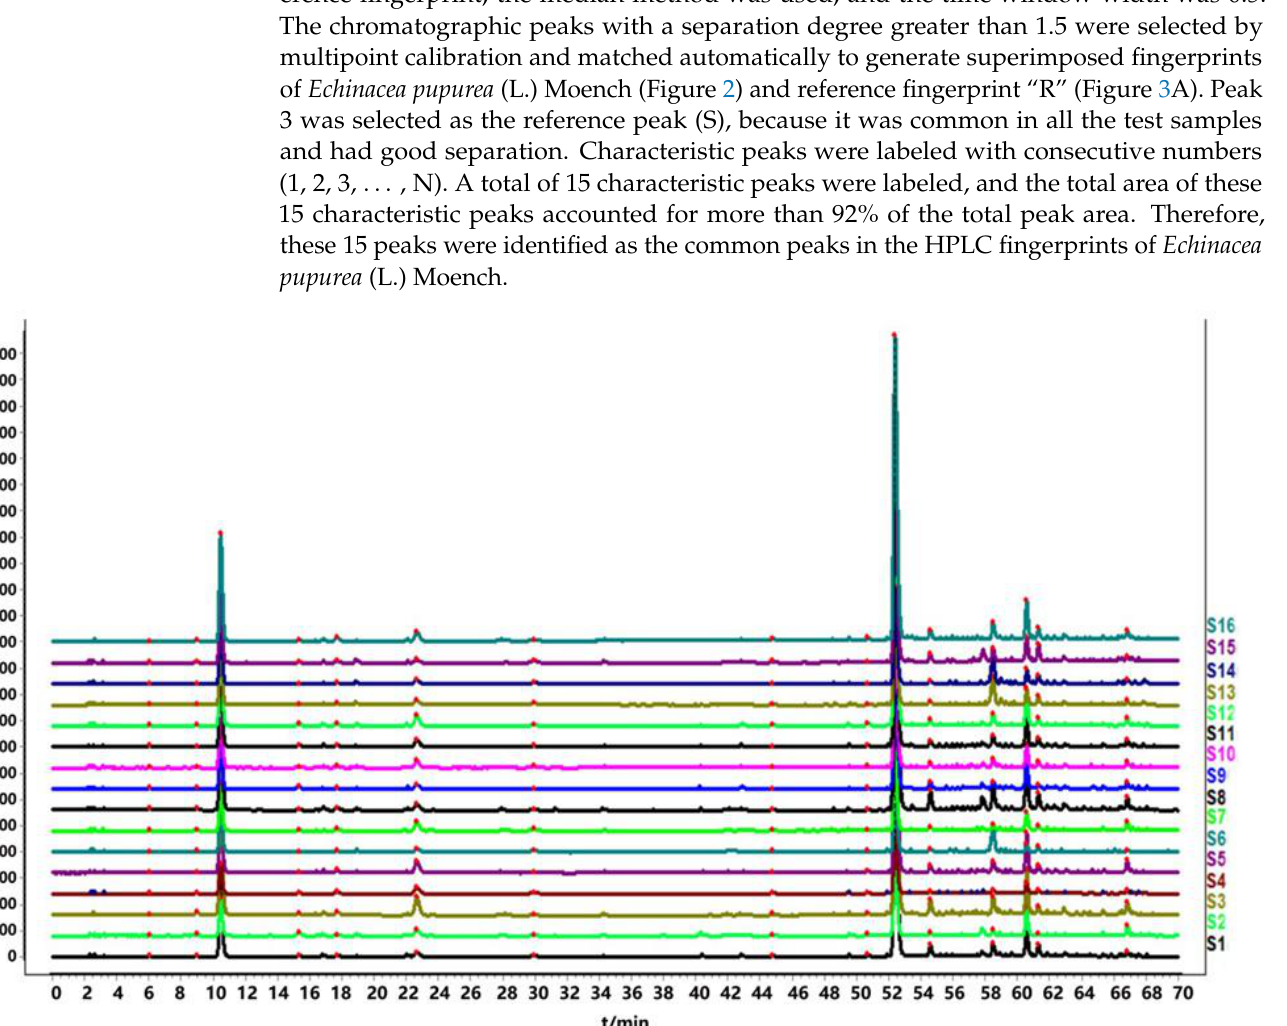
Figure 2. Superimposed fingerprints of 16 batches of Echinacea purpurea from different habitats.